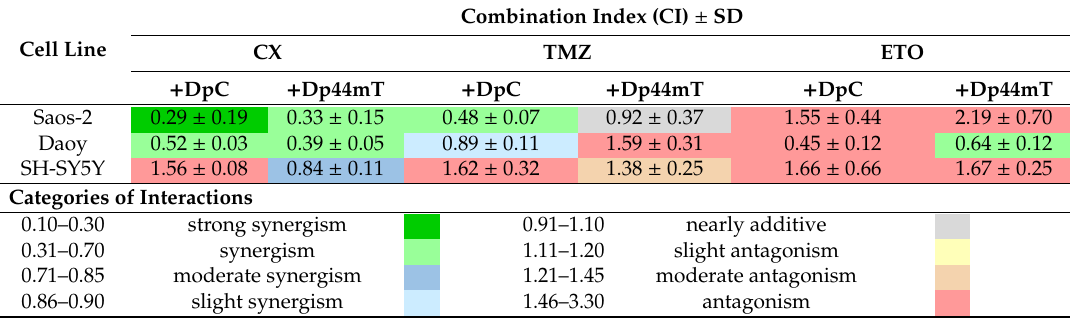
Table 2. Quantitative assessment of drug interactions—combination index (CI) values. Analysis of the interaction between CX, TMZ, or ETO, and the thiosemicarbazones (DpC and Dp44mT) was performed using CalcuSyn software. The data were obtained after a 72 h / 37 ◦ C incubation with each agent alone or in combination. The CIs were calculated from growth inhibition curves. A 1:1 ratio of drugs was used for combination treatments. The Chou Talalay method was adopted to identify synergistic, additive and antagonistic activity. These results are mean ± SD (three